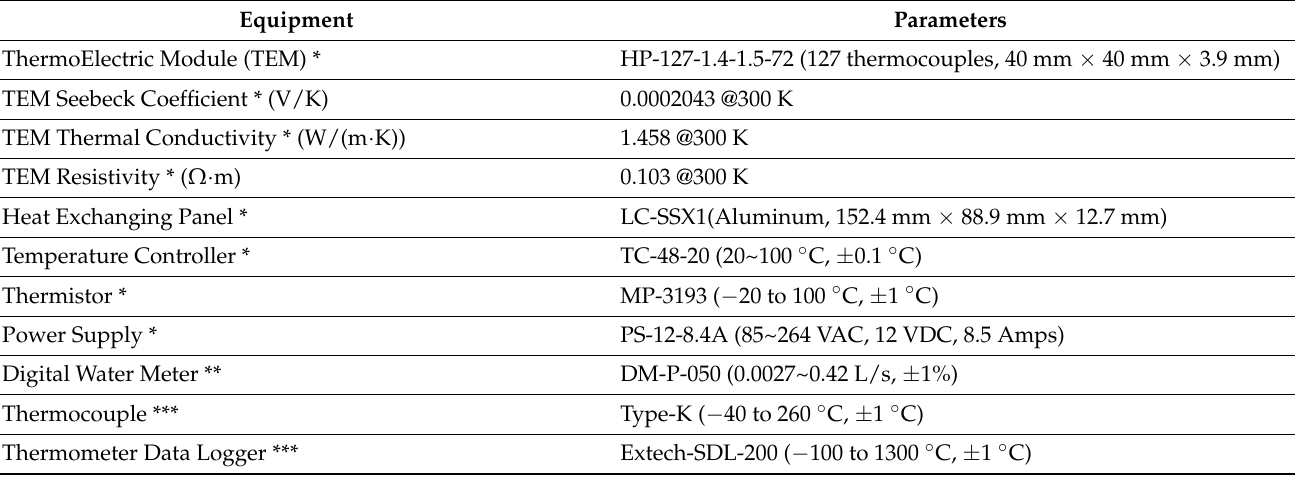
Table 1. Parameters of key experiment